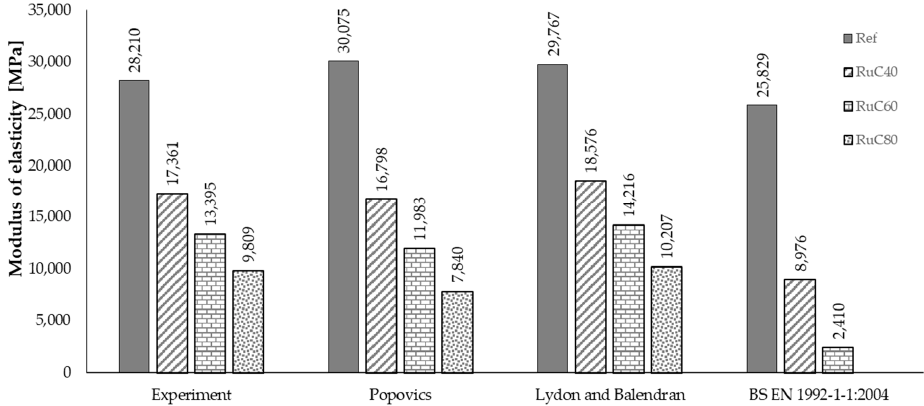
Figure 10. Prediction of the dynamic modulus of elasticity.